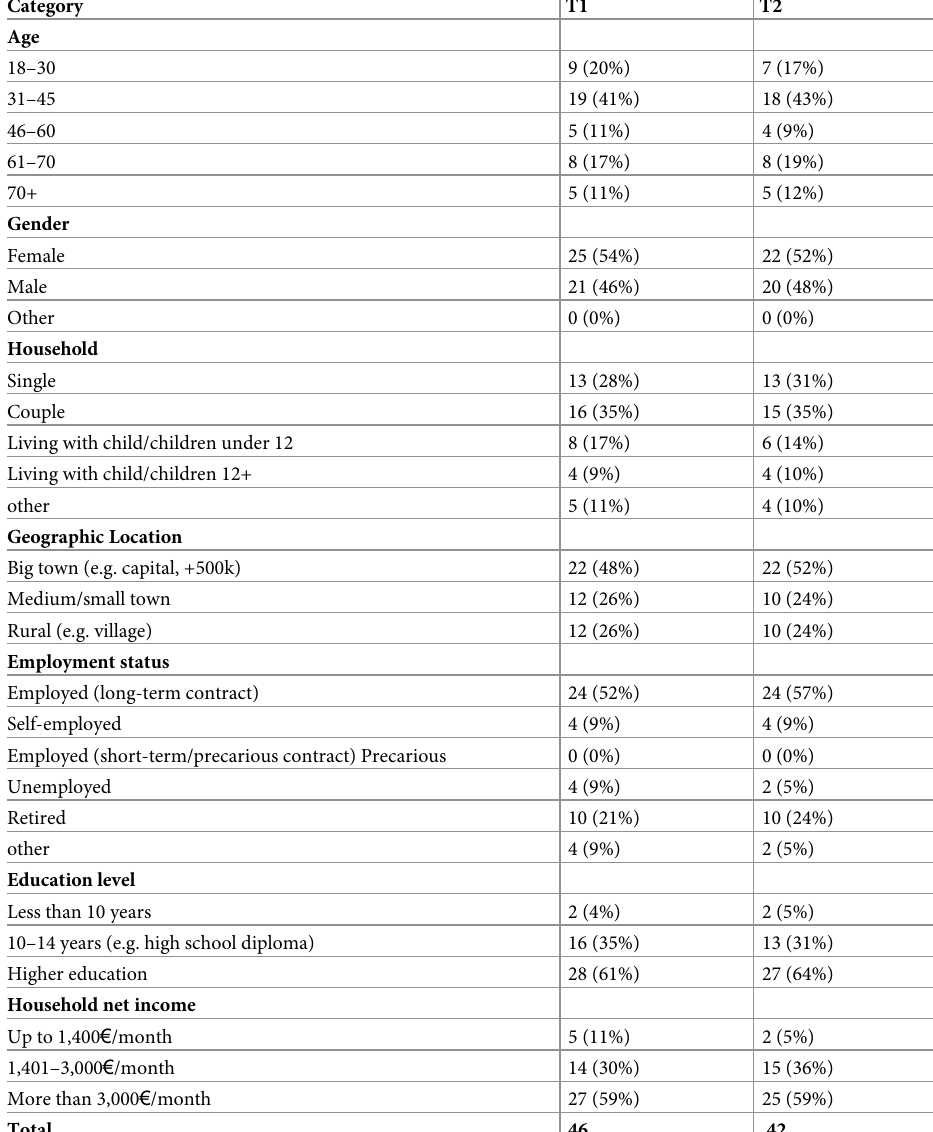
Table 1. Demographic distribution of participants in